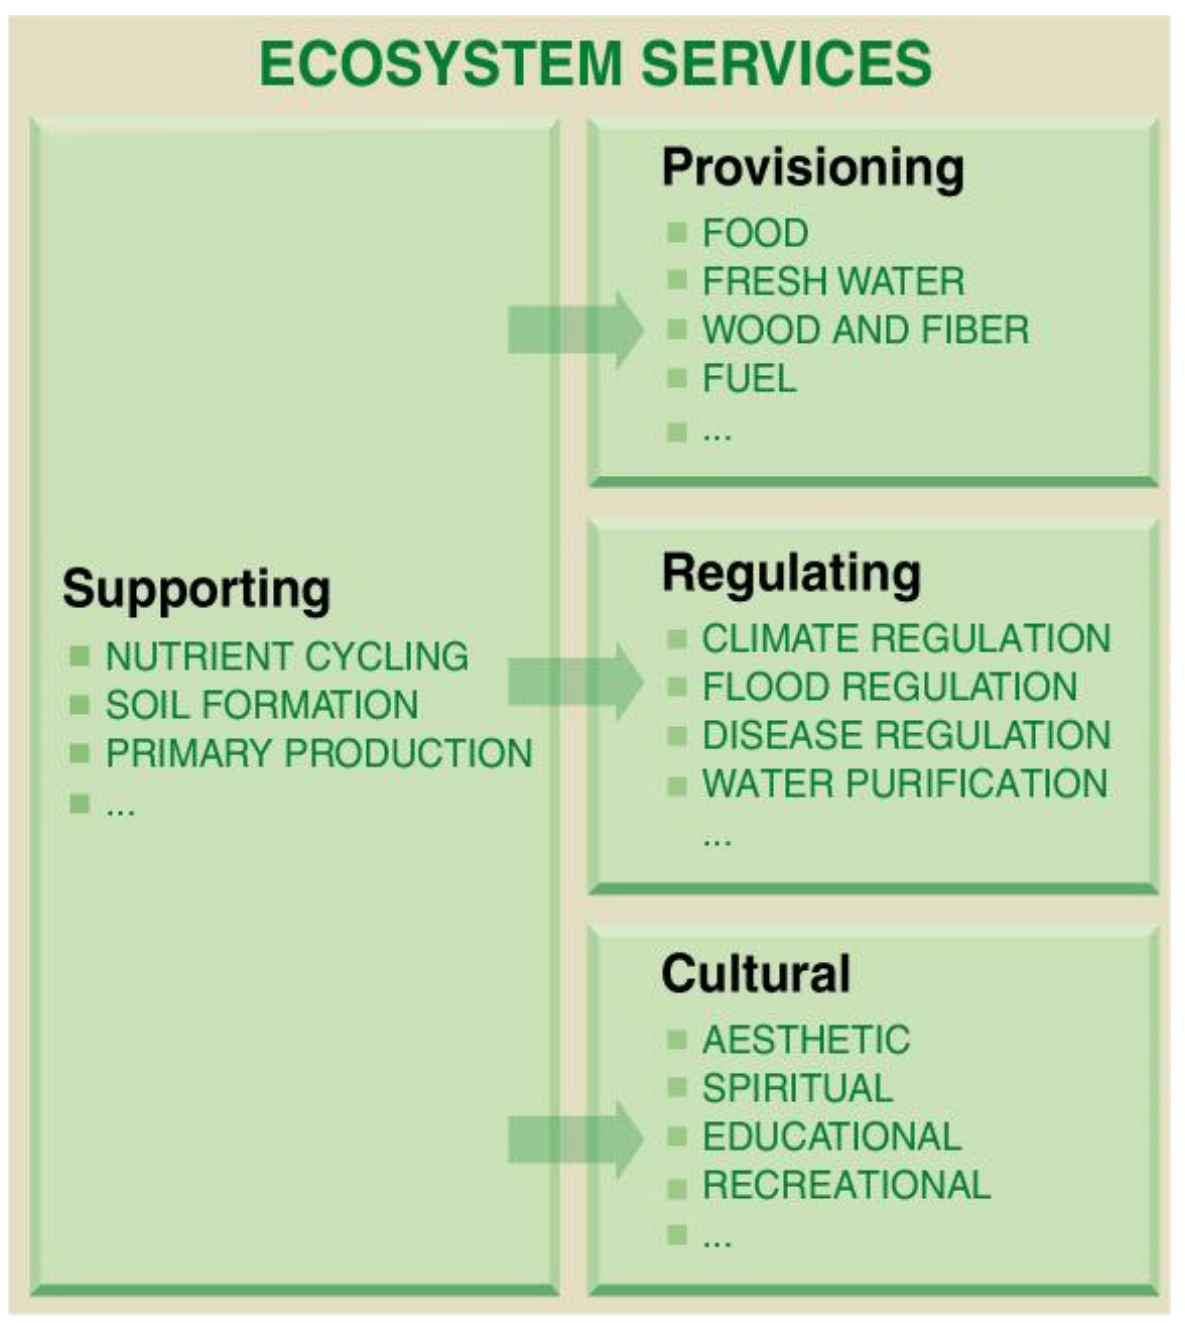
Fig. 1. Ecosystem services are the benefits that people obtain from ecosystems. They include provisioning, regulating, and cultural services that directly affect people, and supporting services needed to maintain the other services. Biodiversity underlies all ecosystem services (source: Millennium Ecosystem Assessment Synthesis Report,